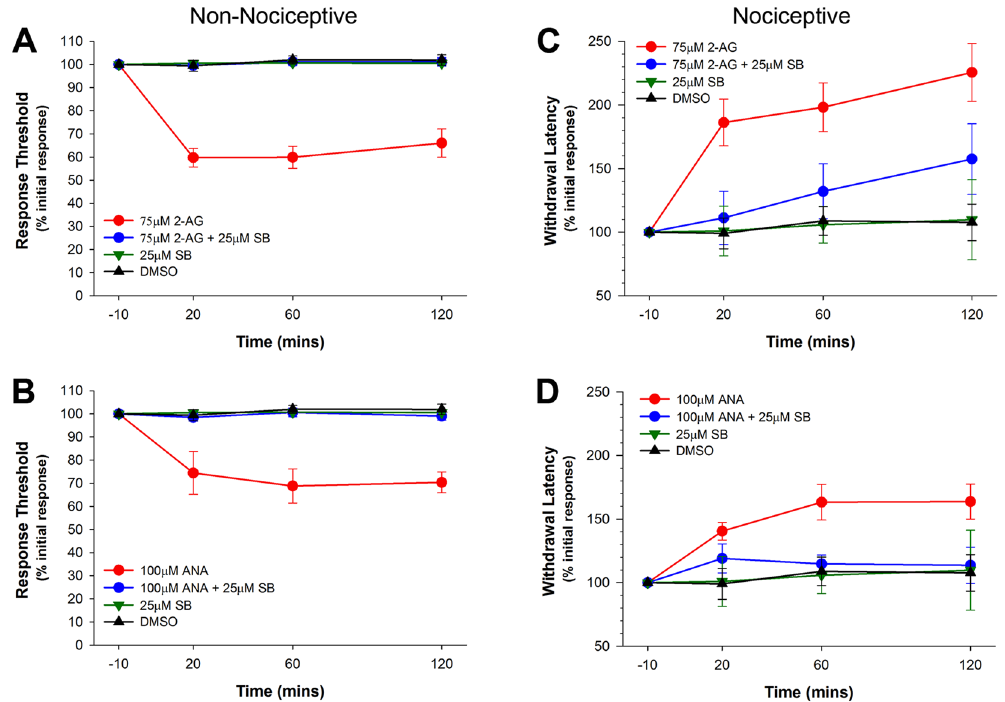
Figure 2. Differential effects of endocannabinoid treatment on responses to non-nociceptive and nociceptive stimuli in non-injured animals. ( A ) Injection of 2-AG reduced the response threshold to non-nociceptive mechanical stimuli and this effect was blocked by co-injection of the TRPV1 inhibitor SB366791 (SB). ( B ) Injection of anandamide (ANA) also reduced the response threshold to non-nociceptive mechanical